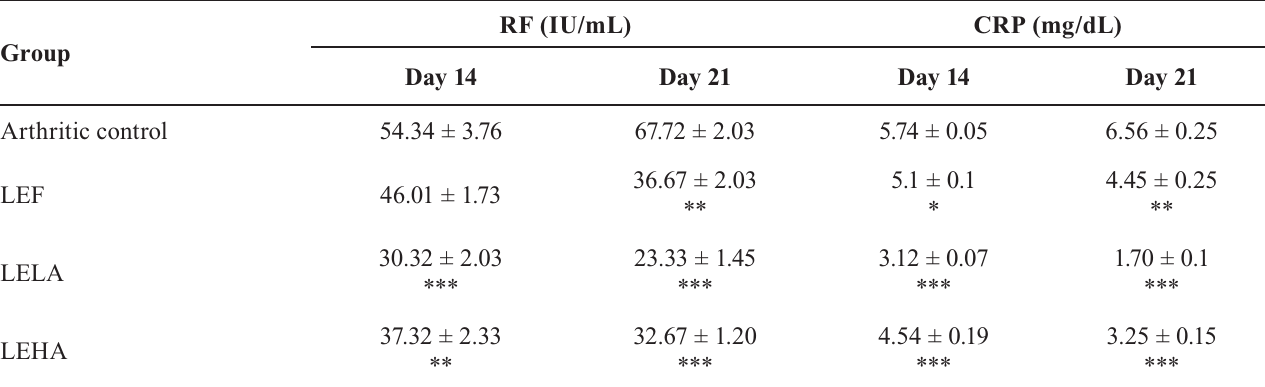
TABLE XI- E ffect of leflunomide and amitriptyline on RF and CRP in FCA induced arthritic rats